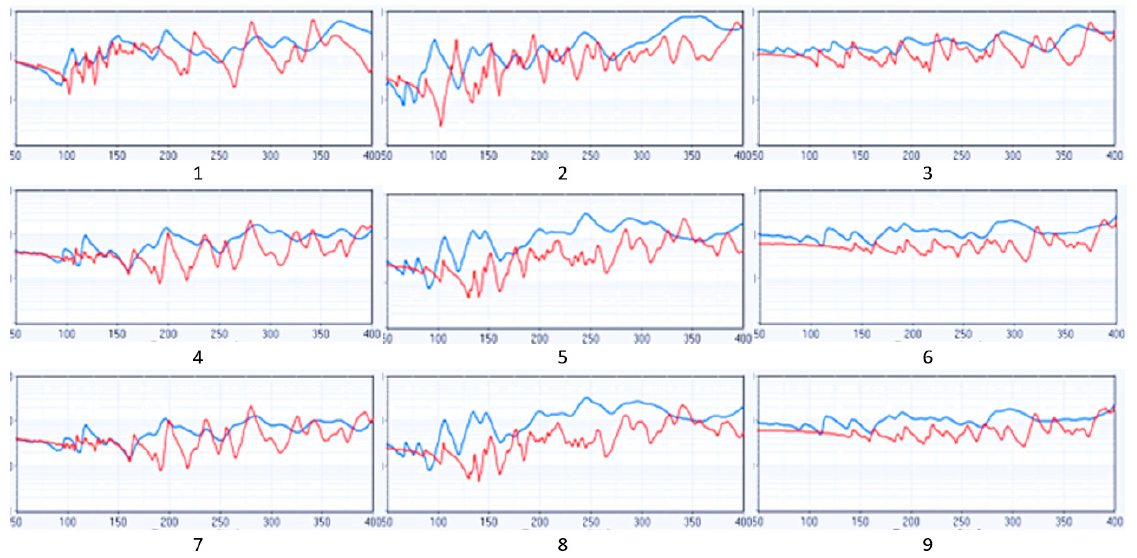
Figure 18. Dynamic stiffness of the car roof vs. frequency in each monitoring point (Figure 11): PP23CF component, with the optimized structure (blue line) and TCA component (red line).